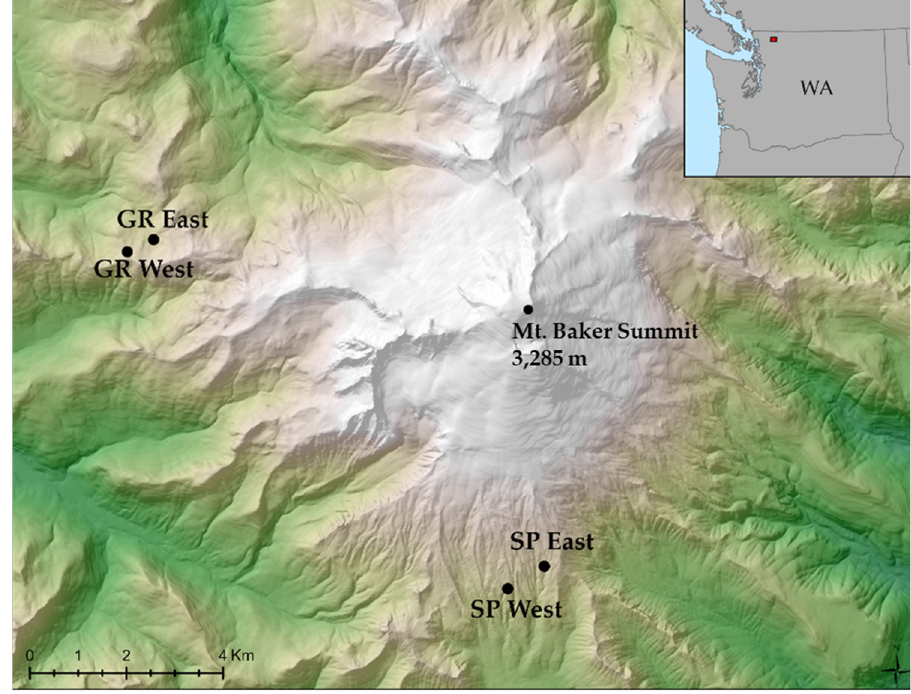
Figure 1. Study site locations. The two transects along the Scott Paul (SP) Trail are both south facing, and the two transects on Grouse Ridge (GR) are both north Facing.